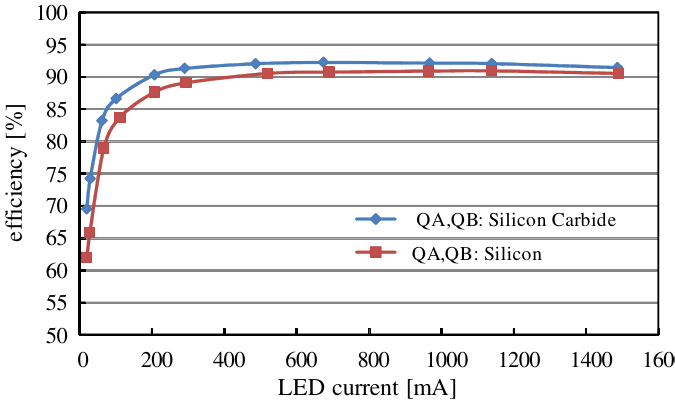
Figure 27. Experimental results of the efficiency for the output current I LED